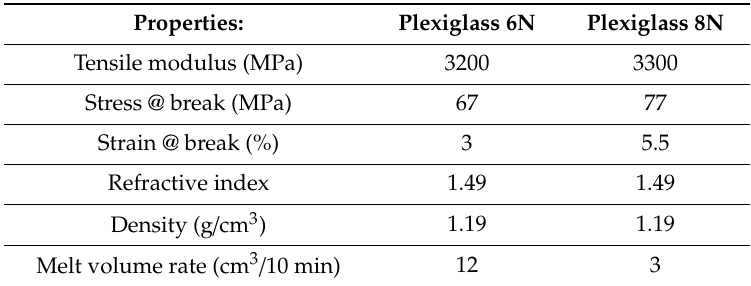
Table 1. Properties of Plexiglass 6N and 8N.